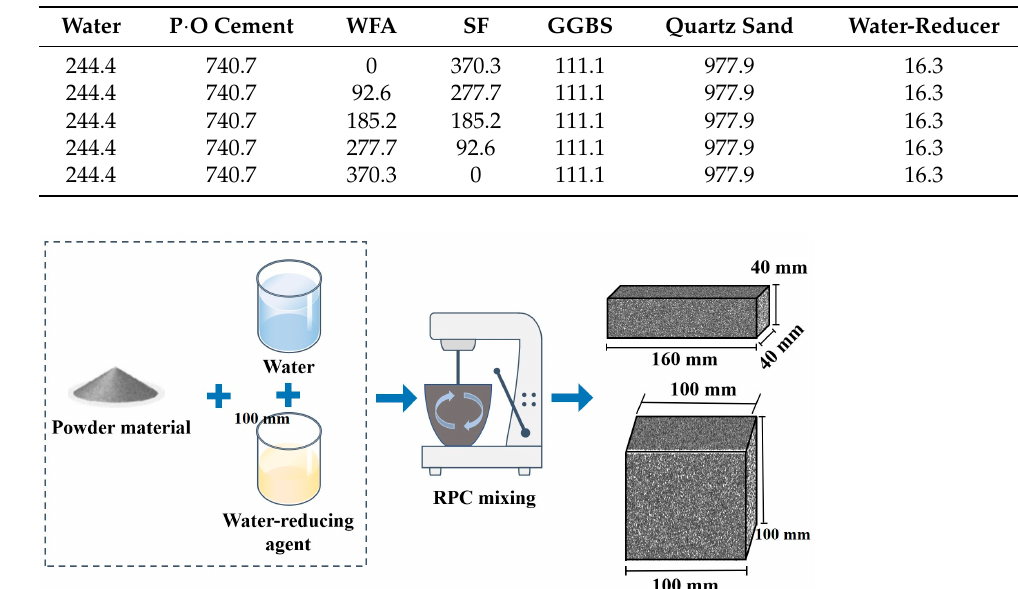
Table 3. Mixture design of RPC per one cubic meter (kg).